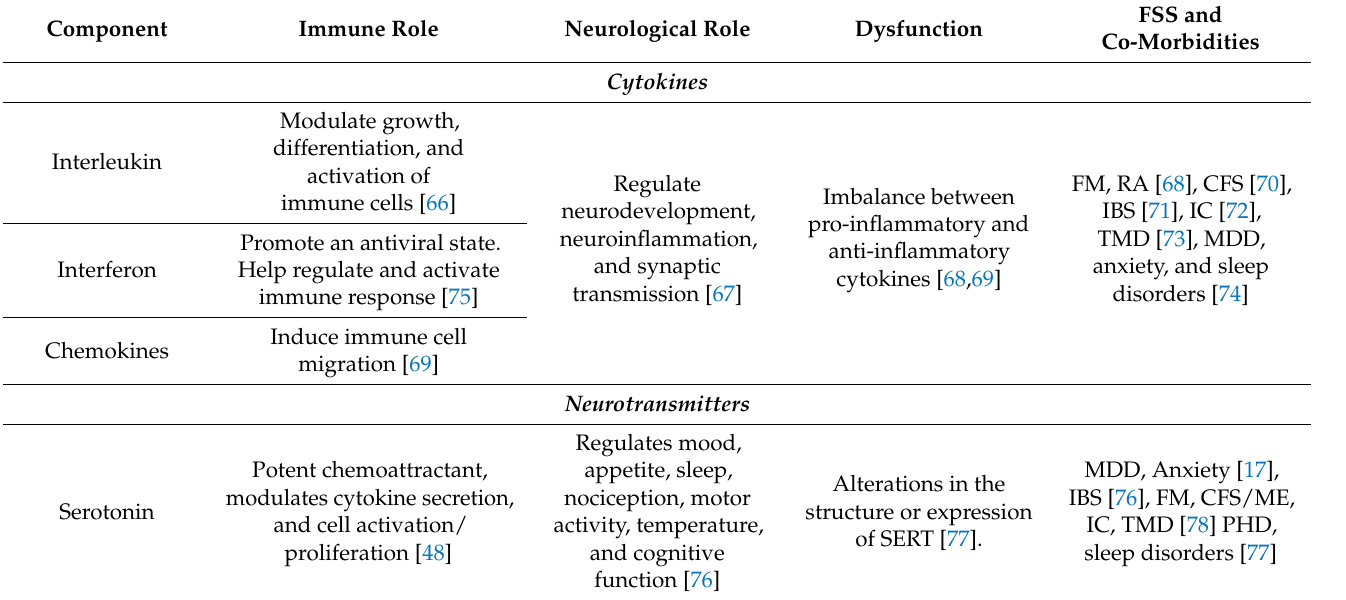
Table 2. Outlining the roles of varying components of both the nervous and immune systems where dysfunction is associated with